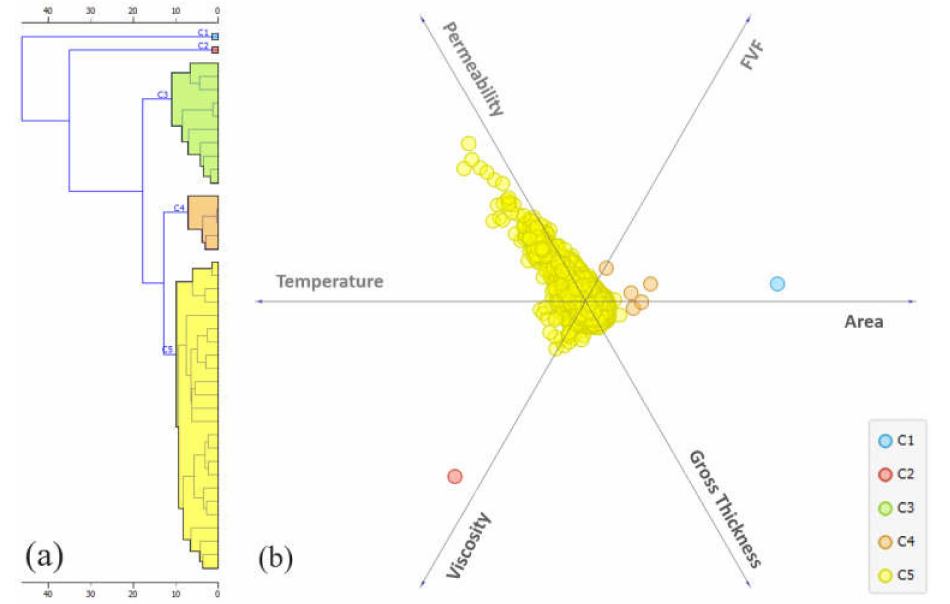
Figure 10. ( a ) Hierarchical clustering of Basin X data into 5 distinct clusters in 11-dimensional space. ( b ) Multivariant linear projection of attributes area, FVF, gross thickness, permeability, temperature and viscosity. Colours indicate Clusters C1–C5 and demonstrate that outliers are captured well by hierarchical clustering. Plot from Orange Data Mining software [27].